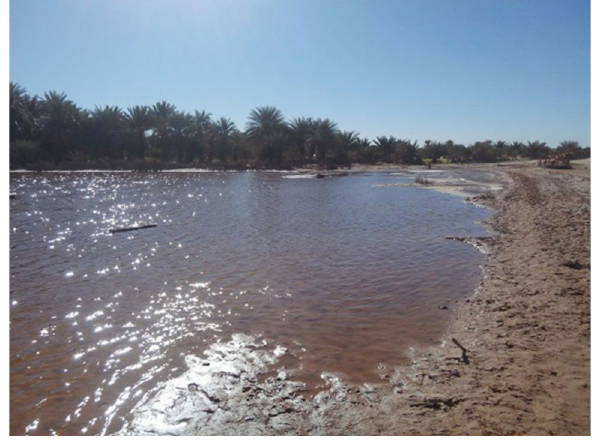
Fig. 19 Flooding of Kesibat palm groves. (photo. Authors